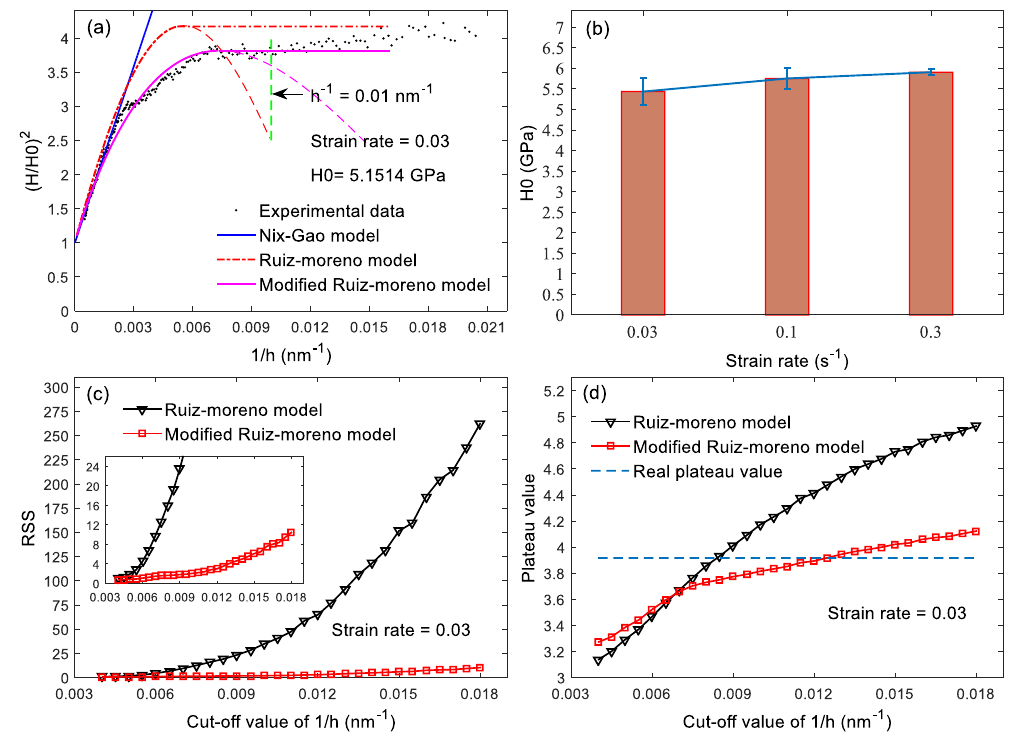
2 (cid:16) (cid:17) 2 ) H versus h −1 of strain versus h − 1 of strain 𝐻 0 H 0